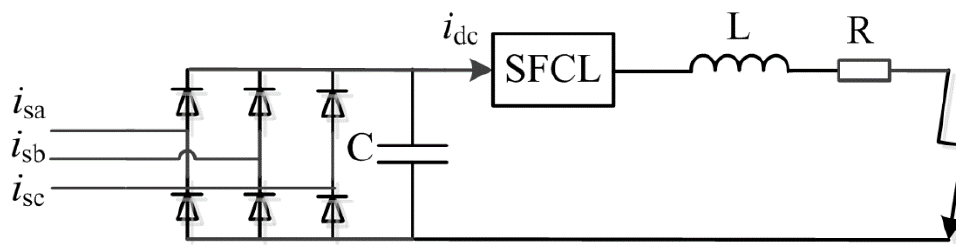
Figure 7. The uncontrolled